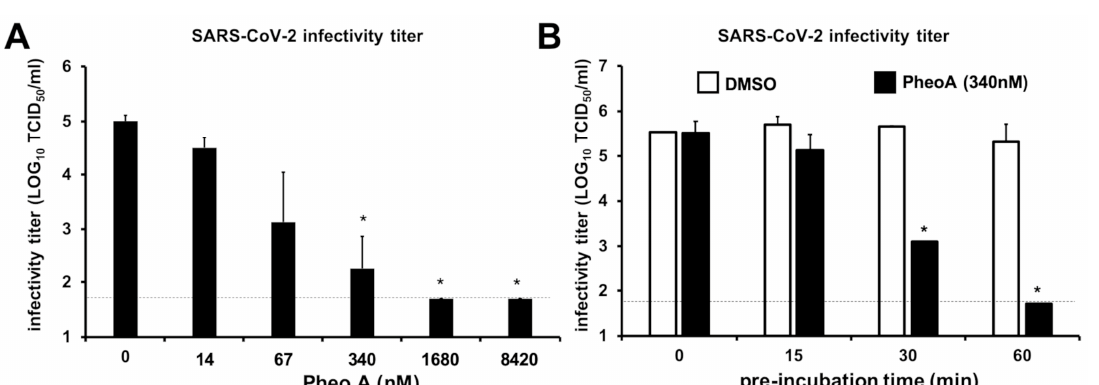
Figure 8. PheoA interferes with SARS-CoV-2 virion infectivity in a dose- and time-dependent manner. SARS-CoV-2 virus stocks were diluted to obtain 1 × 10 5 TCID 50 /mL and were mixed with increasing concentrations of PheoA or the vehicle (DMSO). ( A ) Dose-dependent reduction in SARS-CoV-2 infectivity by PheoA. Virus-compound mixtures were incubated at room temperature for 30 min and were serially diluted to determine the remaining infectivity titer using endpoint dilution and determination of virus-induced cytopathic effect by crystal violet staining in Vero-E6 cells. ( B ) Pre-incubation time-dependent reduction in SARS-CoV-2 infectivity by PheoA. Experiments were carried out using a fixed dose of PheoA (340 nM) and increasing pre-incubation times before serial dilution for TCID 50 determination. Values are expressed as LOG TCID 50 /mL and shown as the average and standard deviation of three independent experiments ( n = 3). Statistical significance was estimated using one-way ANOVA and a Dunnet’s post hoc test (* p <